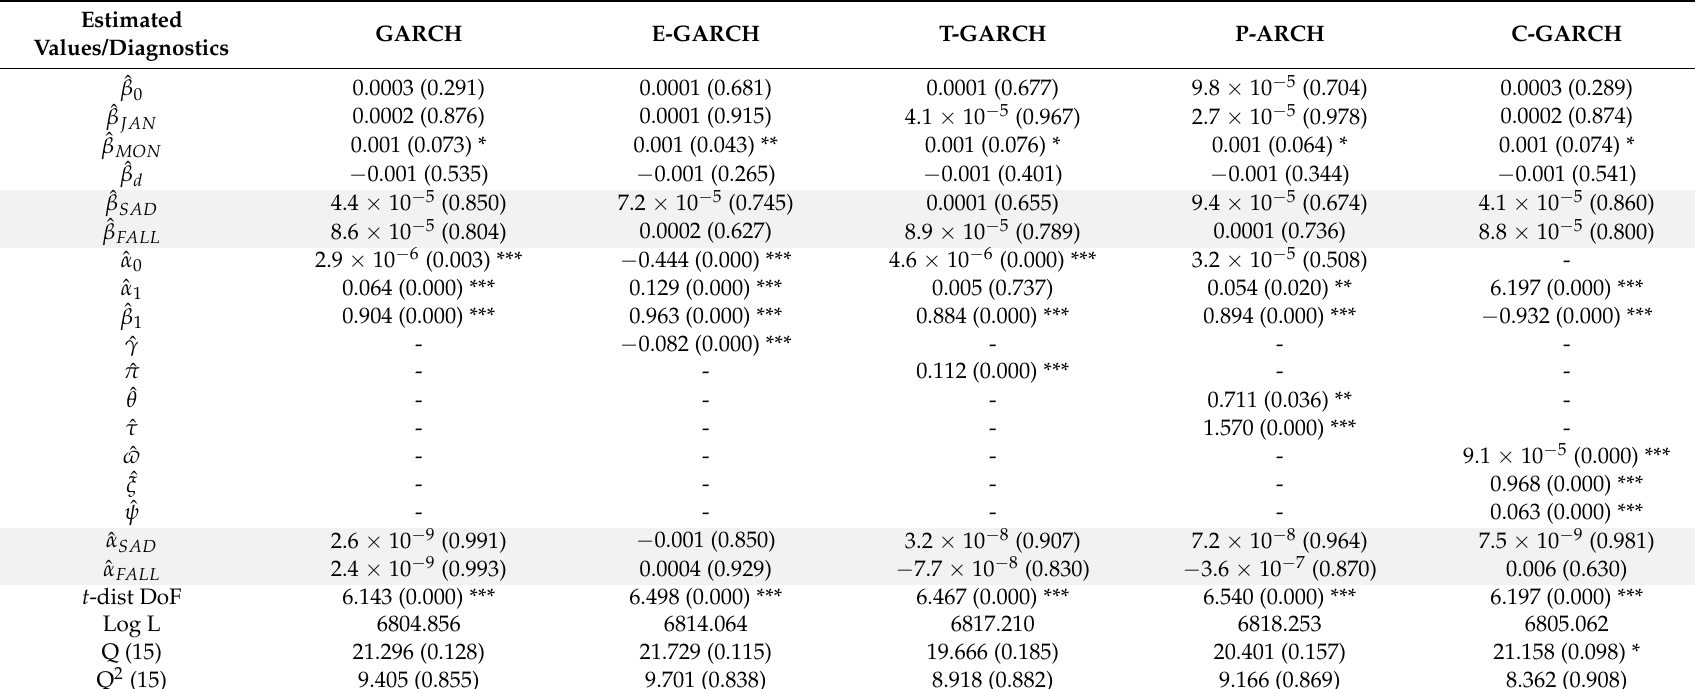
Table A11. Different GARCH specifications for